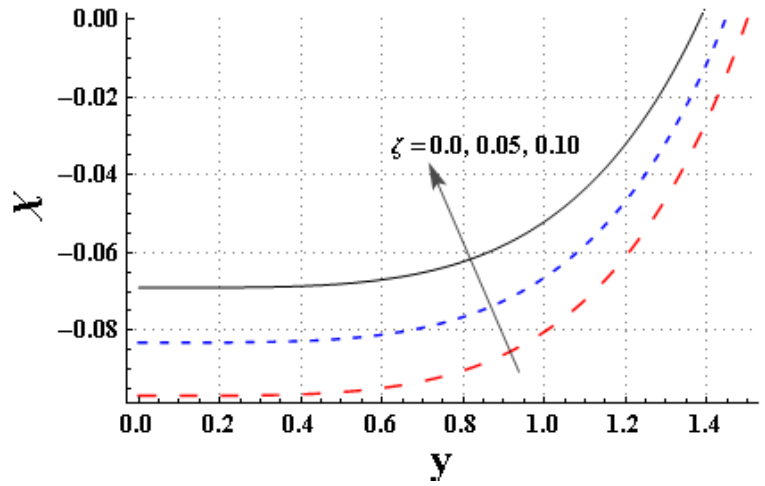
  , on the concentration of motile microorgan- , on the concentration of motile microorgan-